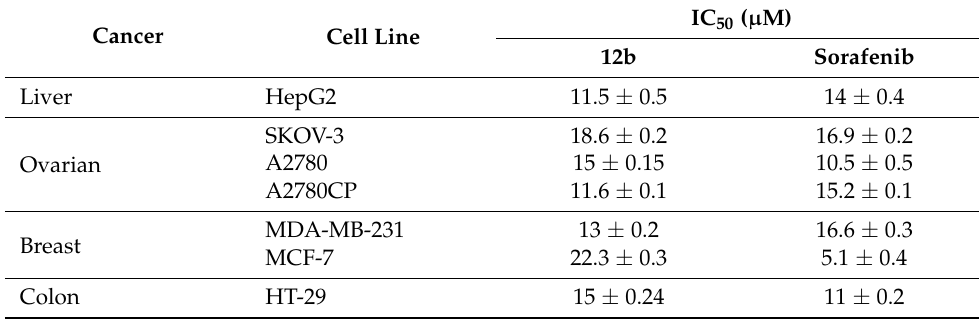
Table 1. IC 50 values for compound 12b against different types of cancers.